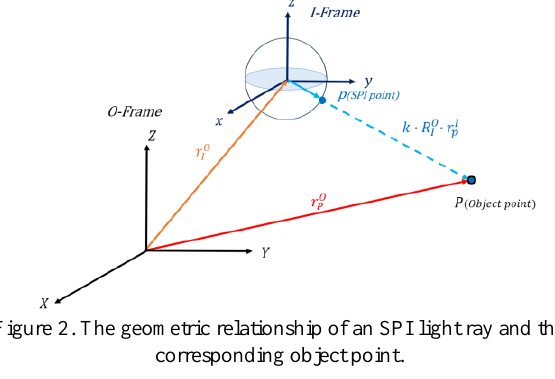
Figure 2. The geometric relationship of an SPI light ray and the corresponding object point.